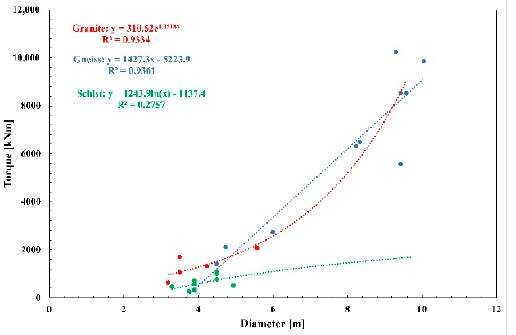
Figure 10. Correlation between the diameter and the torque due to the excavation in granites, gneisses and shales by open TBMs.